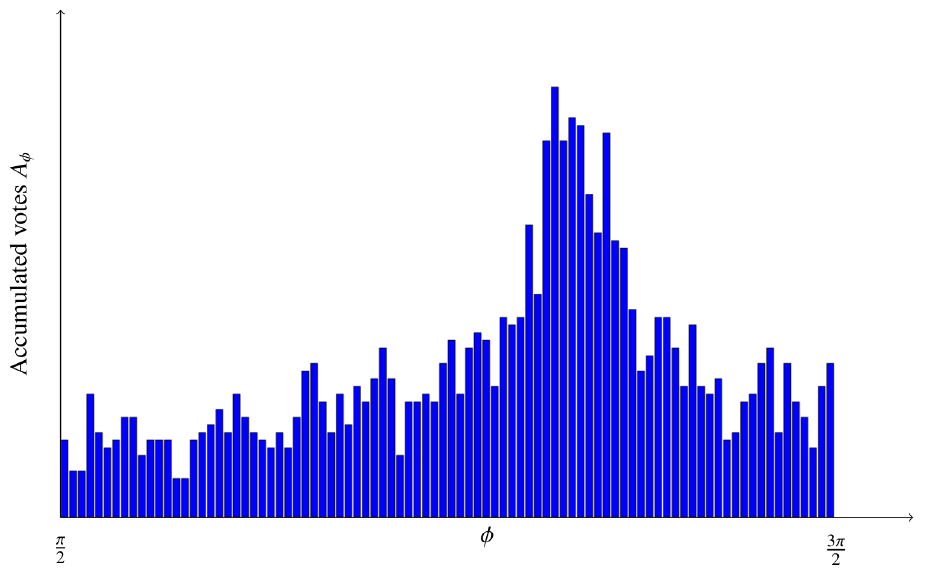
p ,3 p (cid:2) is shown. 2 4